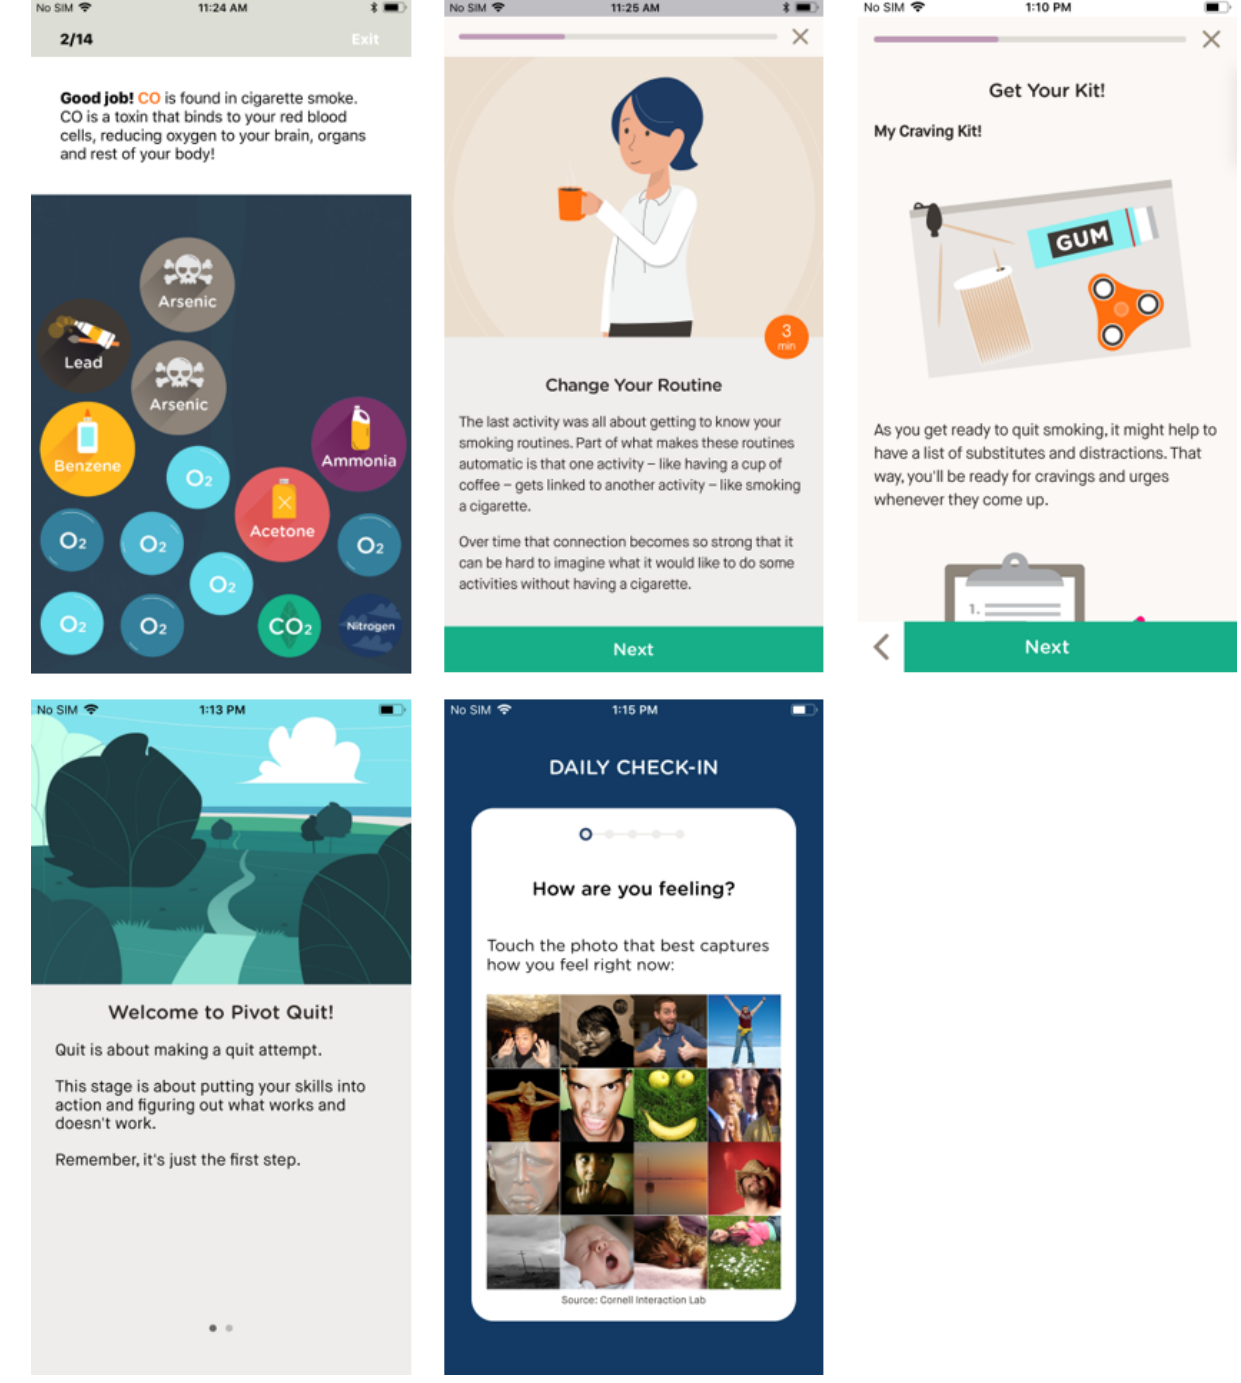
Figure 2. Sample screenshots from the Pivot app, different